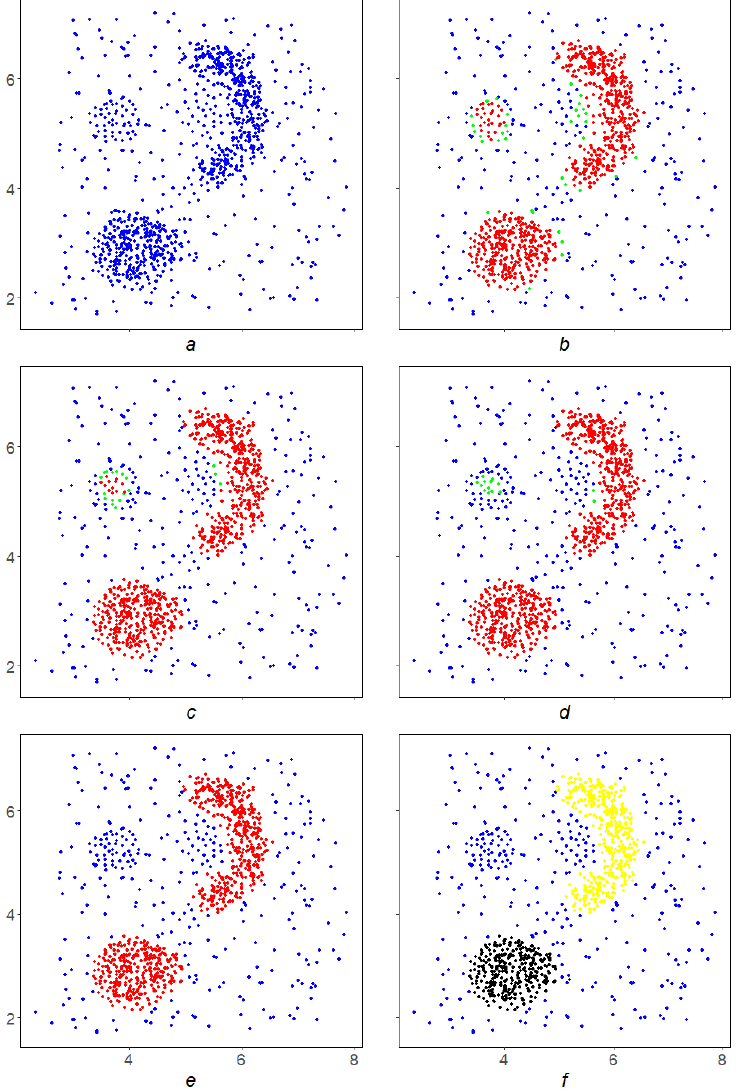
Figure 2. Application of the SDPS algorithm to the array X ( a ). Four iterations are shown in figures ( b – e ). The result is a local α -perfect subset of X ( α ) in X ( e ). The green points in figures ( b – d ) show the points that did not pass the next iteration in SDPS. SDPS further splits X ( α ) into connected components (( f ), yellow and black